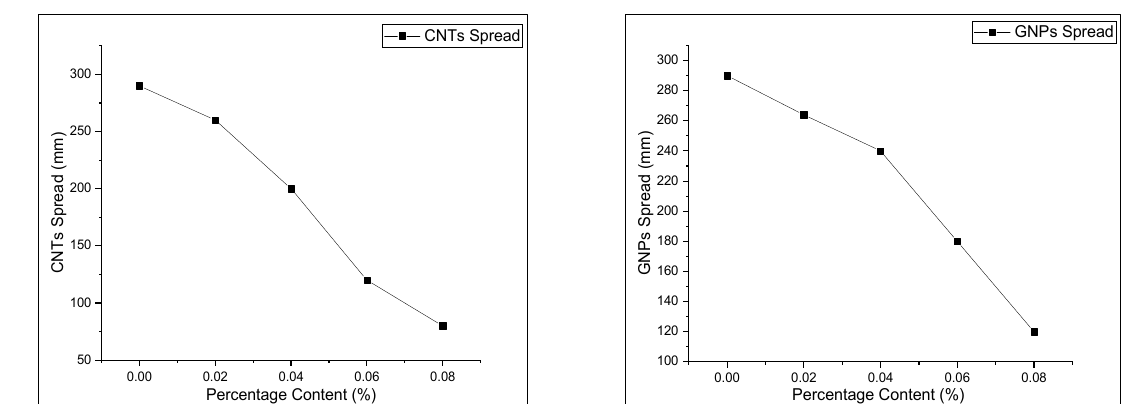
Figure 10. CNTs and GNPs spread using a mini-slump cone by varying different